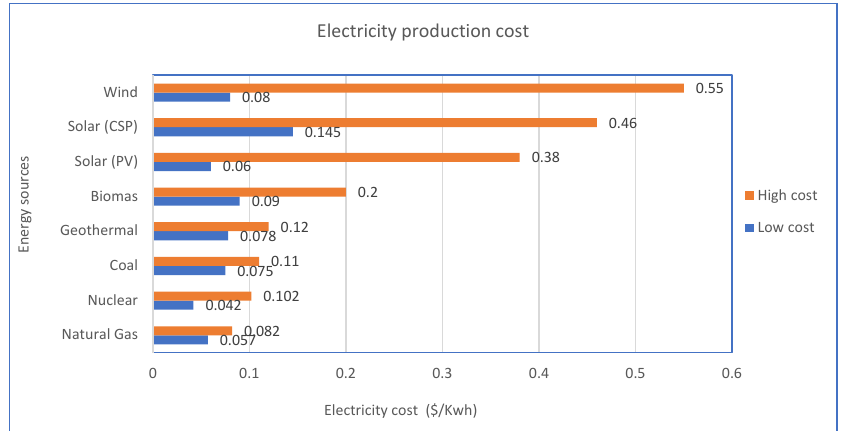
Figure 21. Electricity production cost for different energy sources.